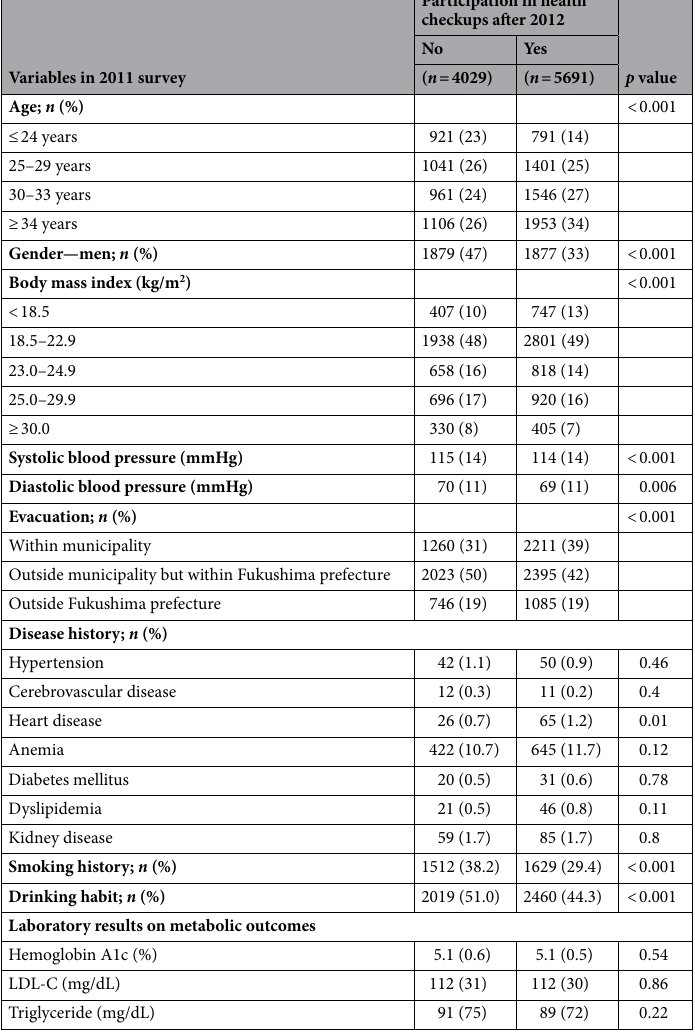
Table 1. Comparison of study participants after classifying participation status after the 2012 survey. The numbers (percentages of non-participation or control groups) are shown. Two-group comparisons between the non-participation cohort and the control were performed with the independent t-tests and Pearson’s chi- square tests on continuous and categorical data, respectively. LDL-C low-density lipoprotein